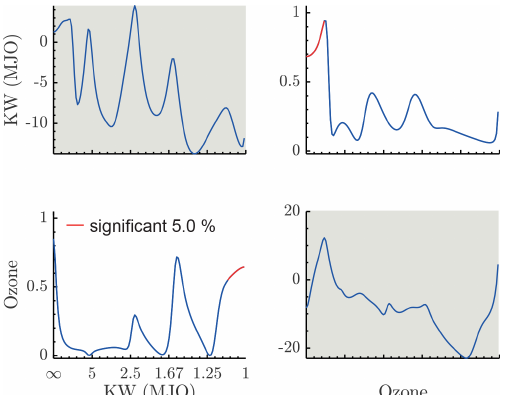
Figure 6. PDC analysis of the interaction of ozone modes and Kelvin waves (KWs) at the slow timescale (periods given in years). The results show that KWs influence ozone on the annual timescale, while ozone influences KWs on decadal timescales. Figure conven- tions are the same as in Fig. 4.